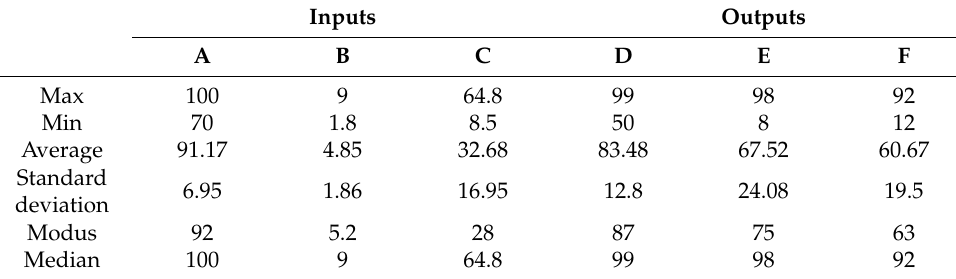
Table 11. Descriptive statistics of inputs and outputs used.